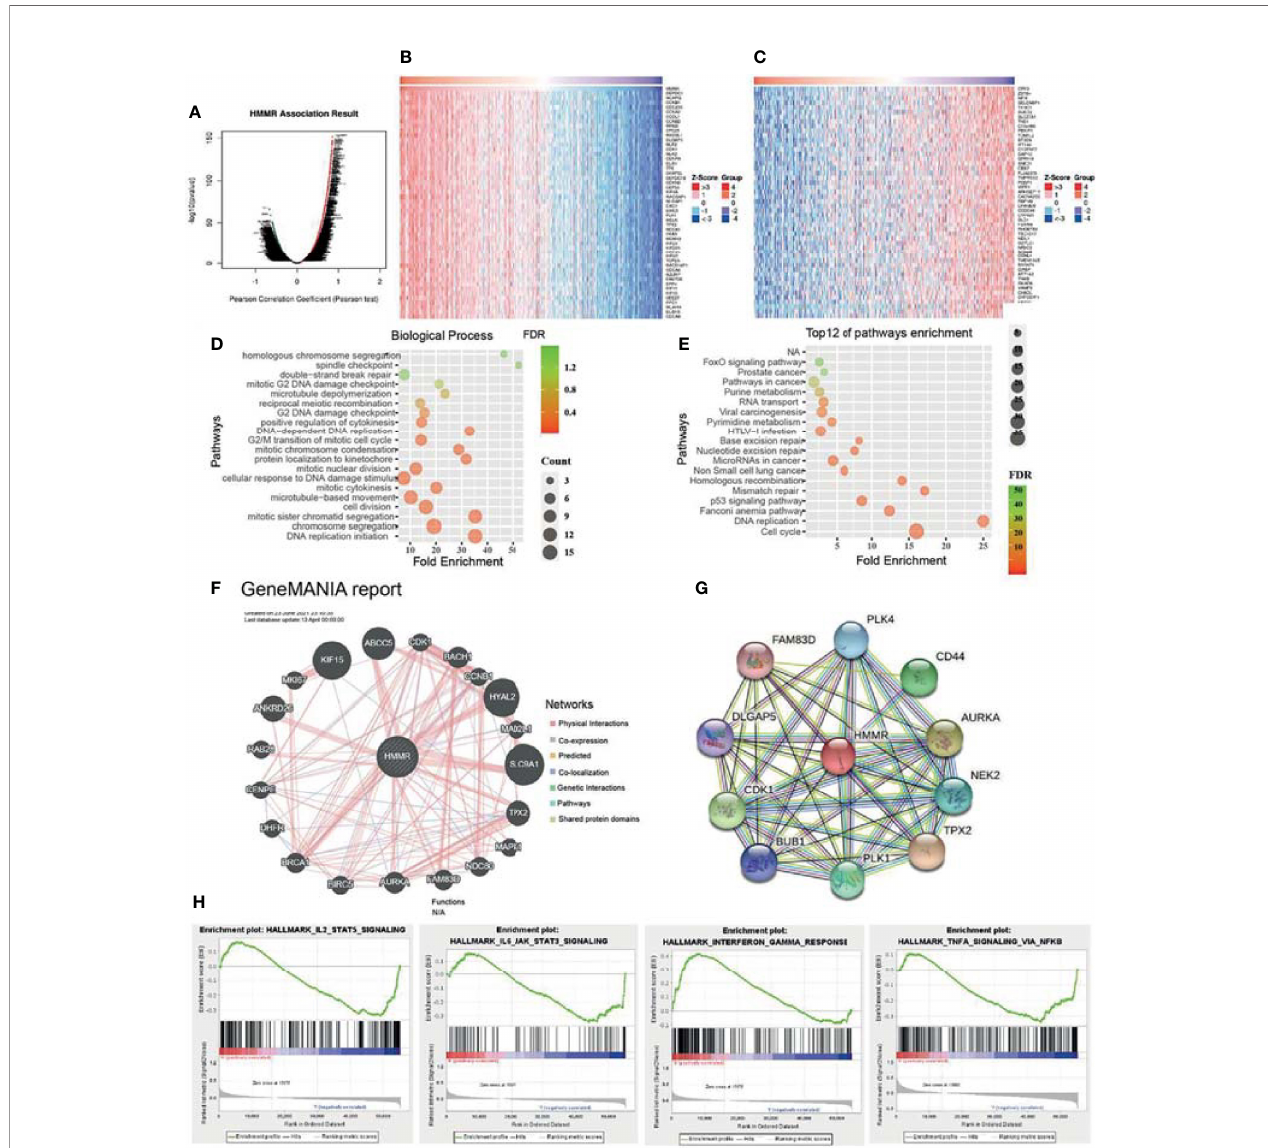
FIGURE 5 | Kyoto Encyclopedia of Genes and Genomes (KEGG) pathways of hyaluronan-mediated motility receptor ( HMMR ) in lung adenocarcinoma (LUAD). (A) Differentially expressed genes displayed in a volcano plot. (B, C) Positive and negative correlations with HMMR displayed in a heatmap. (D) Analysis of the biological process of HMMR . (E) Analysis of the KEGG pathways of HMMR . (F) Gene interaction network of HMMR constructed using GeneMANIA. (G) Construction of the protein – protein interaction network of HMMR using STRING. (H) Signaling pathways enriched using gene set enrichment analysis (GSEA)